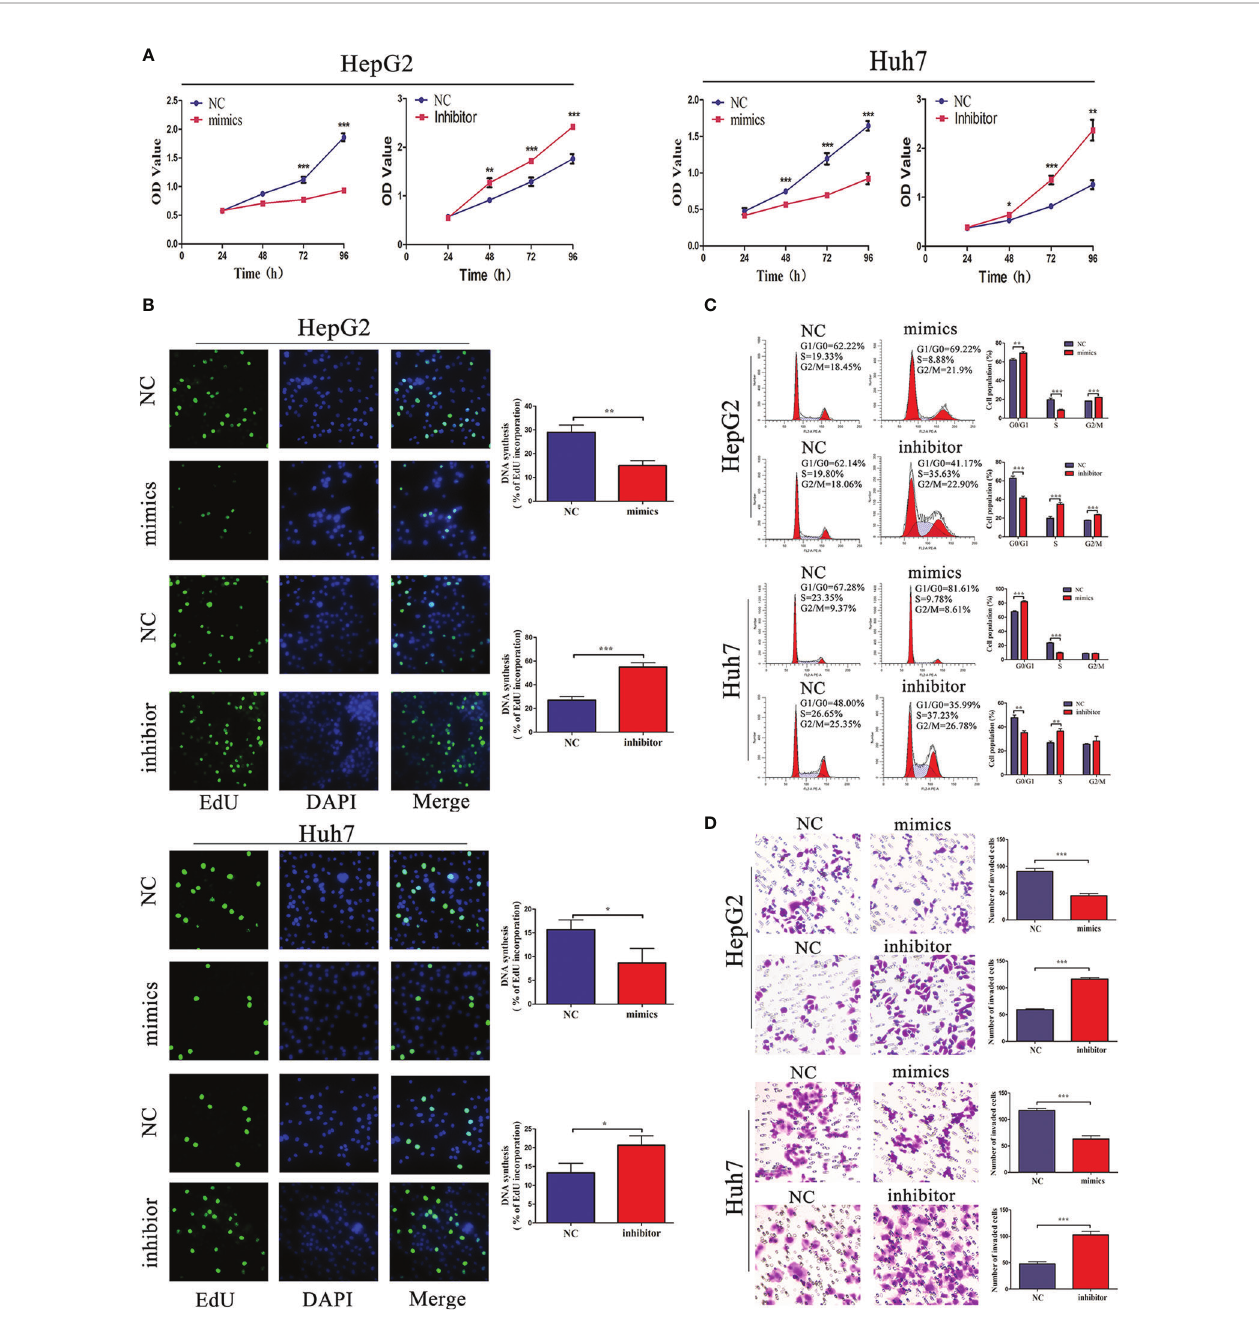
FIGURE 4 | miR-876-5p regulates HCC cell proliferation, cell cycle, and invasion capacity. (A) CCK-8 and (B) EdU assays reveal that miR-876-5p mimics inhibited and inhibitor promoted the proliferation of HCC cells. (C) Flow cytometry reveals that miR-876-5p mimics induced cell cycle arrest, while, miR-876-5p inhibitor accelerated cell cycle. (D) Transwell assays reveal miR-876-5p mimics attenuated, while, inhibitor promoted the invasion of HCC cells. All the above experiments were repeated three times independently; data are presented as mean ± SD; statistical signi fi cance was assessed by Student ’ s t -test. * p < 0.05, ** p < 0.01, *** p <